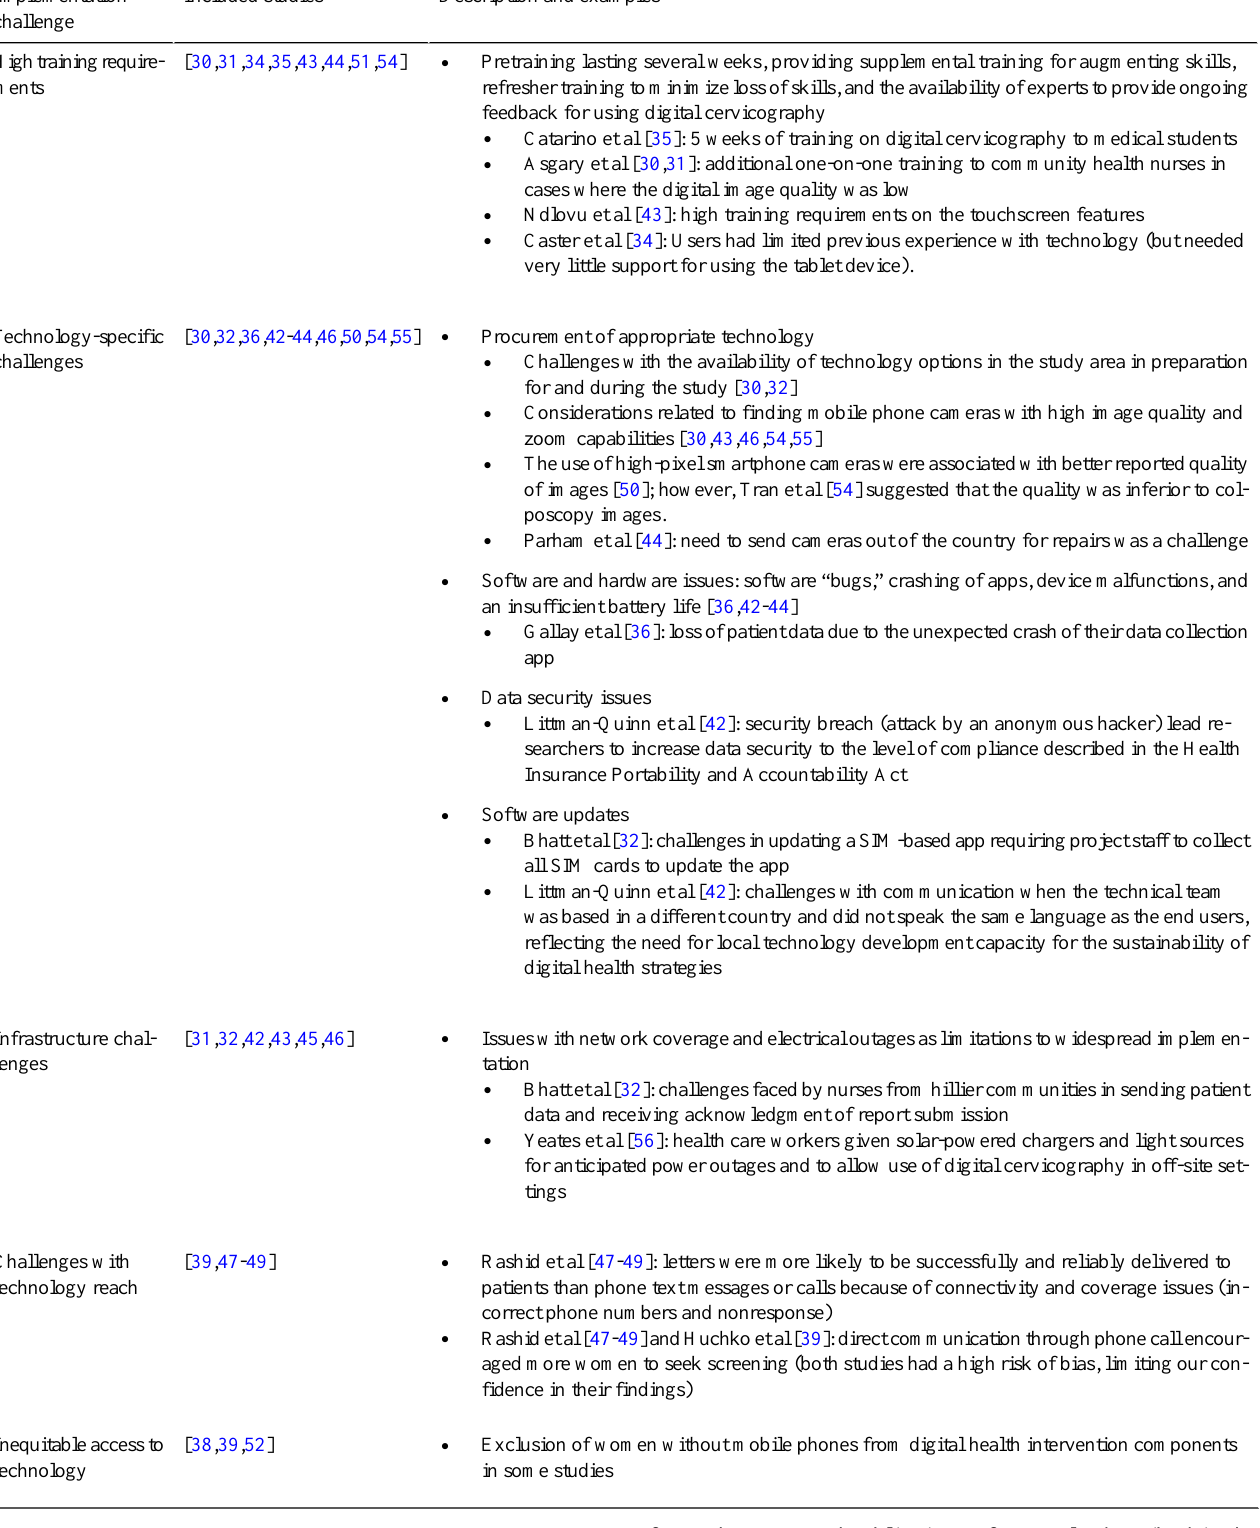
Description and examplesIncluded